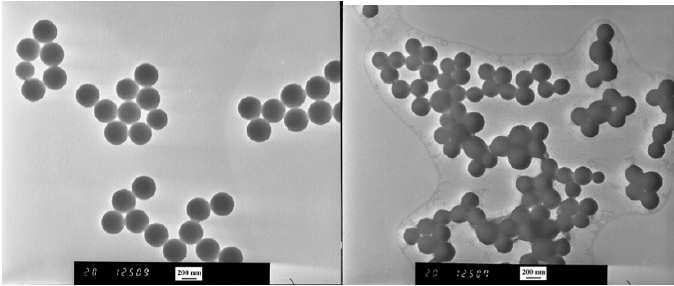
Figure 6. Left transmission electron microscope (TEM) image shows initial PS latex and the right image displays aggregated polystyrene (PS) latex.